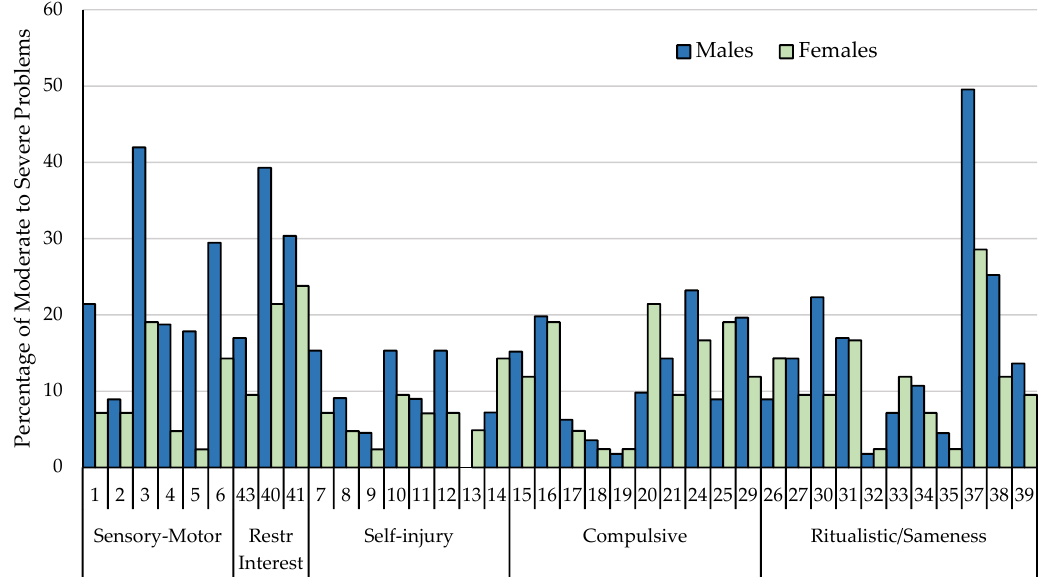
Figure 2. The average percentage of caregivers reporting behaviors to be a moderate to severe problem (a score of 2 or 3) between males and females with fragile X syndrome (FXS) across the RBS-R items.